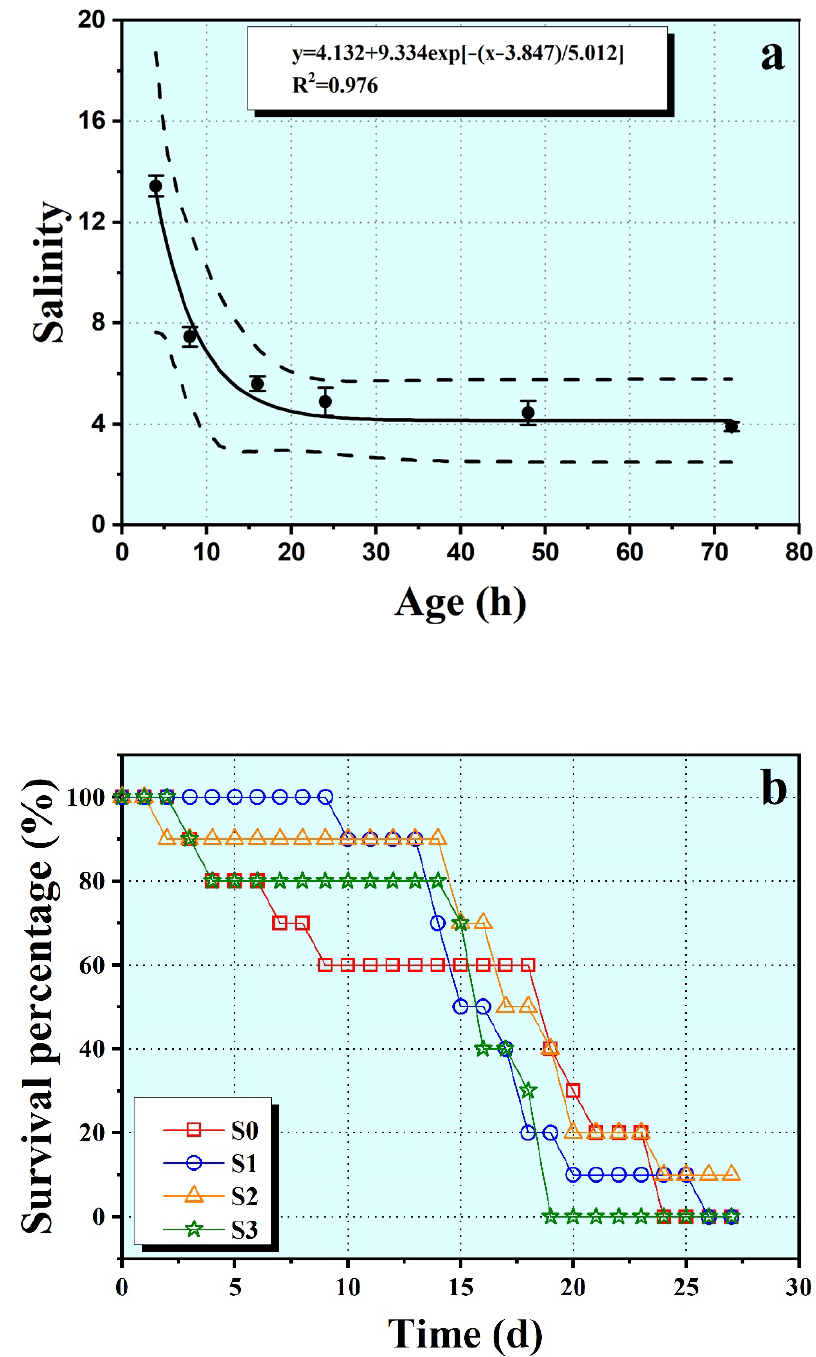
Figure 1. LC 50 s ( a ) between salinity and time and survivorship ( b ) of S. mucronata cultured at different salinity gradients. Values of LC 50 are represented as mean ( ± SE). S0, S1, S2 and S3 represent control, 1, 2 and 3, respectively.